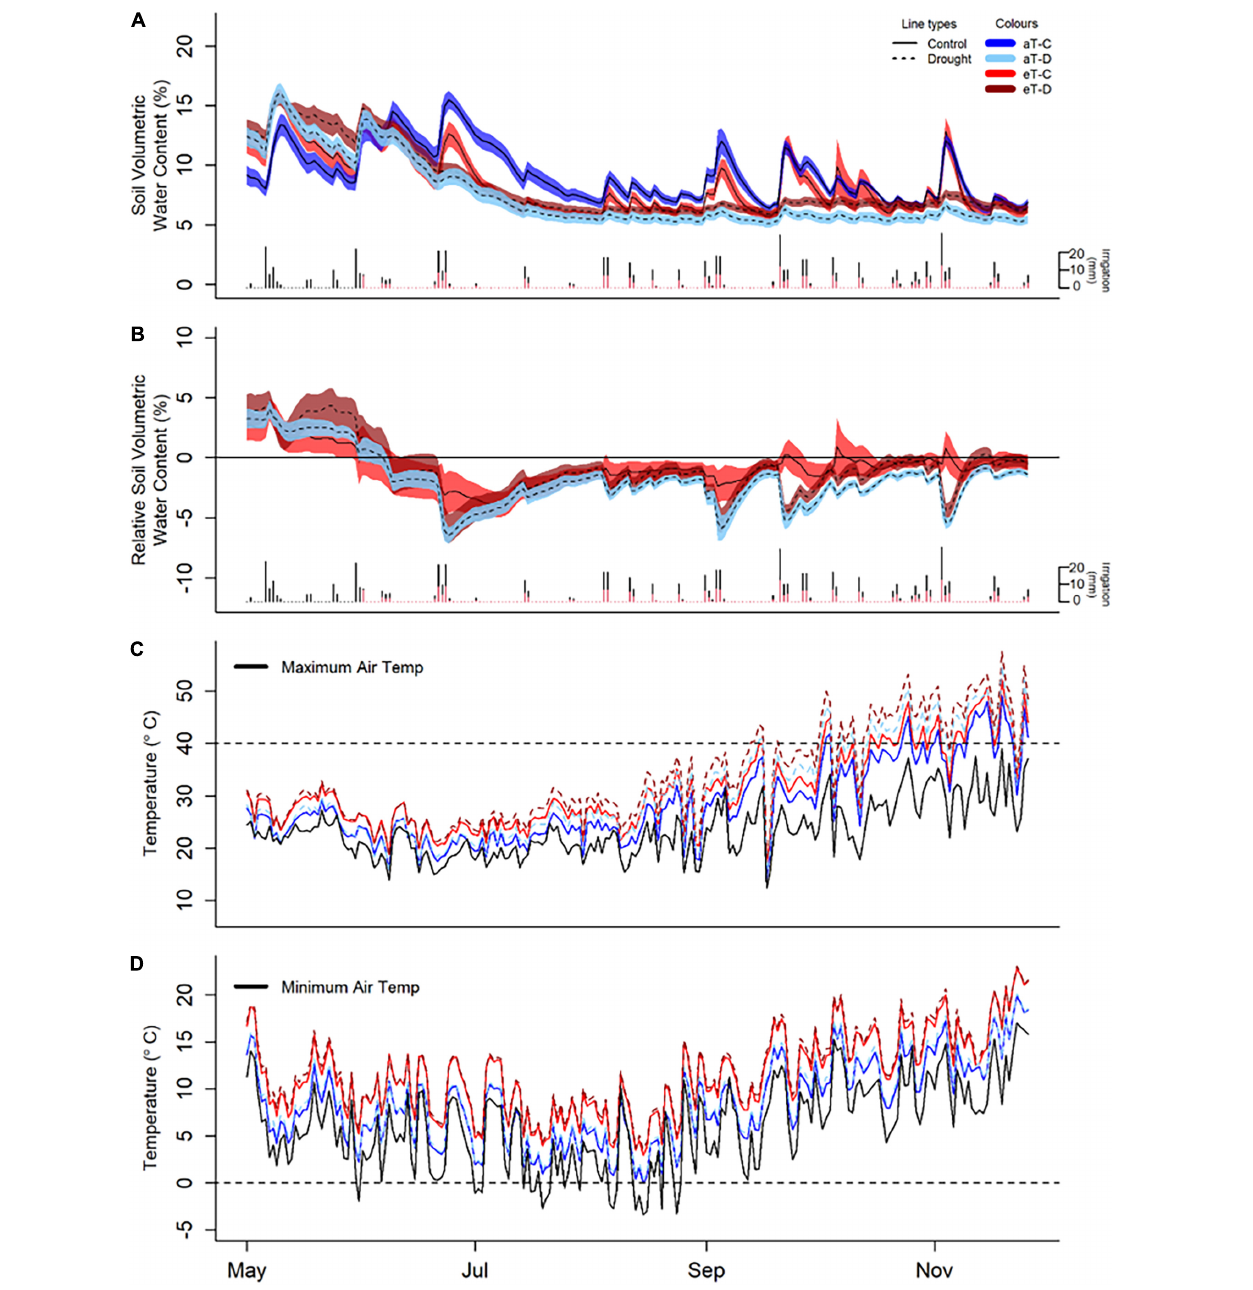
FIGURE 3 | Experimental treatment effects of winter/spring drought (control: C, drought: D) applied during the period between 1 June to 30 November 2019 and year-round warming (ambient temperature: aT, elevated temperature: eT) treatments on soil moisture (A,B) and canopy temperature (C,D) averaged across the six shelters, from 1 May 2019 to 30 November 2019. (A) Average soil volumetric water content in Festuca sub-plots (additional species are shown in Supplementary Figure 2 ) with 95% confidence intervals as well as individual irrigation events as daily rainfall totals for control (black bars) and drought (red bars) plots over the 6-month period of study. (B) Treatment differences in soil water content from aT-C plots over time in the Festuca subplots, noting the winter/spring drought treatment period between 1 June and 30 November 2019. (C) Daily maximum canopy temperature, relative to maximum ambient air temperature (black line) and 40 ◦ C (representing extreme temperatures, dashed lines). (D) Daily minimum temperature compared with minimum air temperature (black line) and 0 ◦ C (dashed lines).